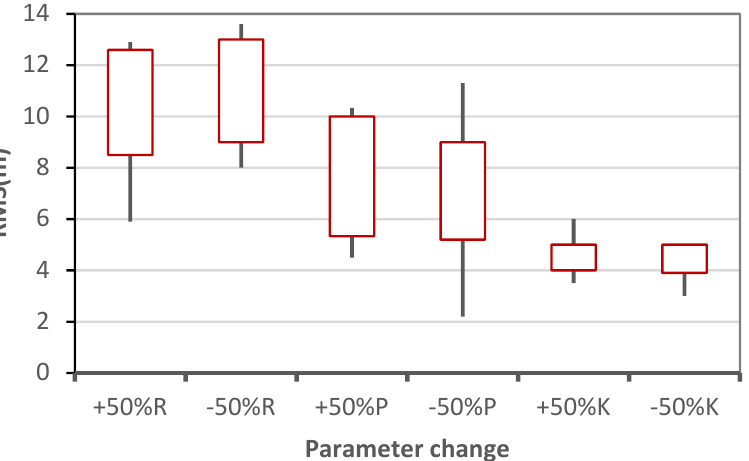
Figure 10. Sensitivity of RMSE to ( ± 50) parameters relative change (Recharge (R), Pumping (P), and Hydraulic conductivity (K).